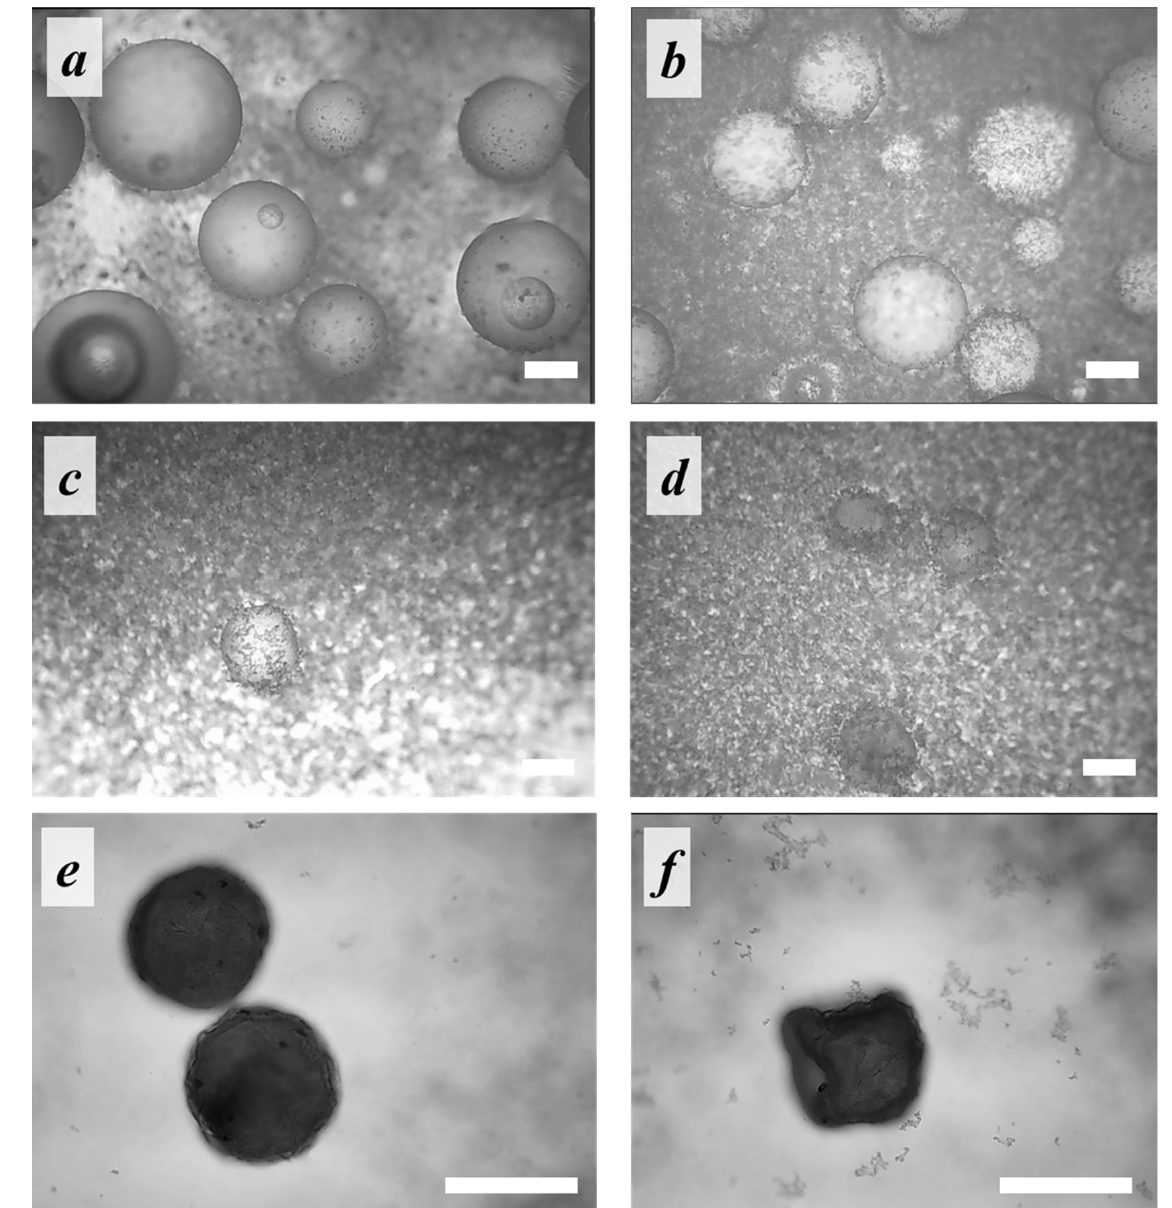
Figure 5. Micrographies acquired under optical transmission microscopes of aliquots of the oil/water emulsion withdrawn at ( a , b ) 5 min, ( c , d ) 85 min, and ( e , f ) 105 min after the dispersion onset. The oil phase—PLA solution; the aqueous phase—1% nHA dispersion obtained using ( a , c , e ) magnetic stirring and ( b , d , f ) US-treatment. Scale bar is 100 µm.